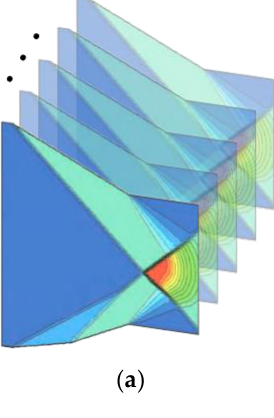
Figure 1. Schematic diagram of the two-dimensional parallel slices in any three-dimensional flow field: ( a ) parallel slices, ( b ) an arbitrary